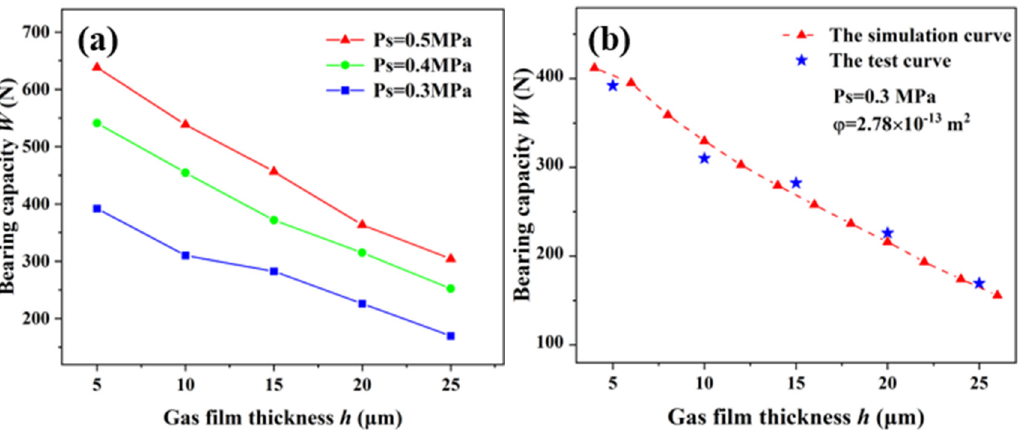
Figure 10. Bearing capacities of aerostatic bearing: ( a ) experimental results; ( b ) comparison of theoretical calculation and experimental results.